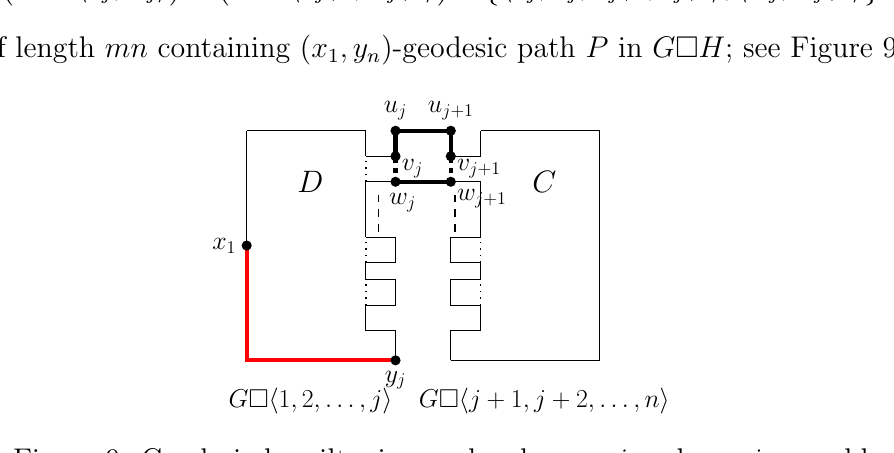
Figure 9: Geodesic hamiltonian cycle when m, j and n − j are